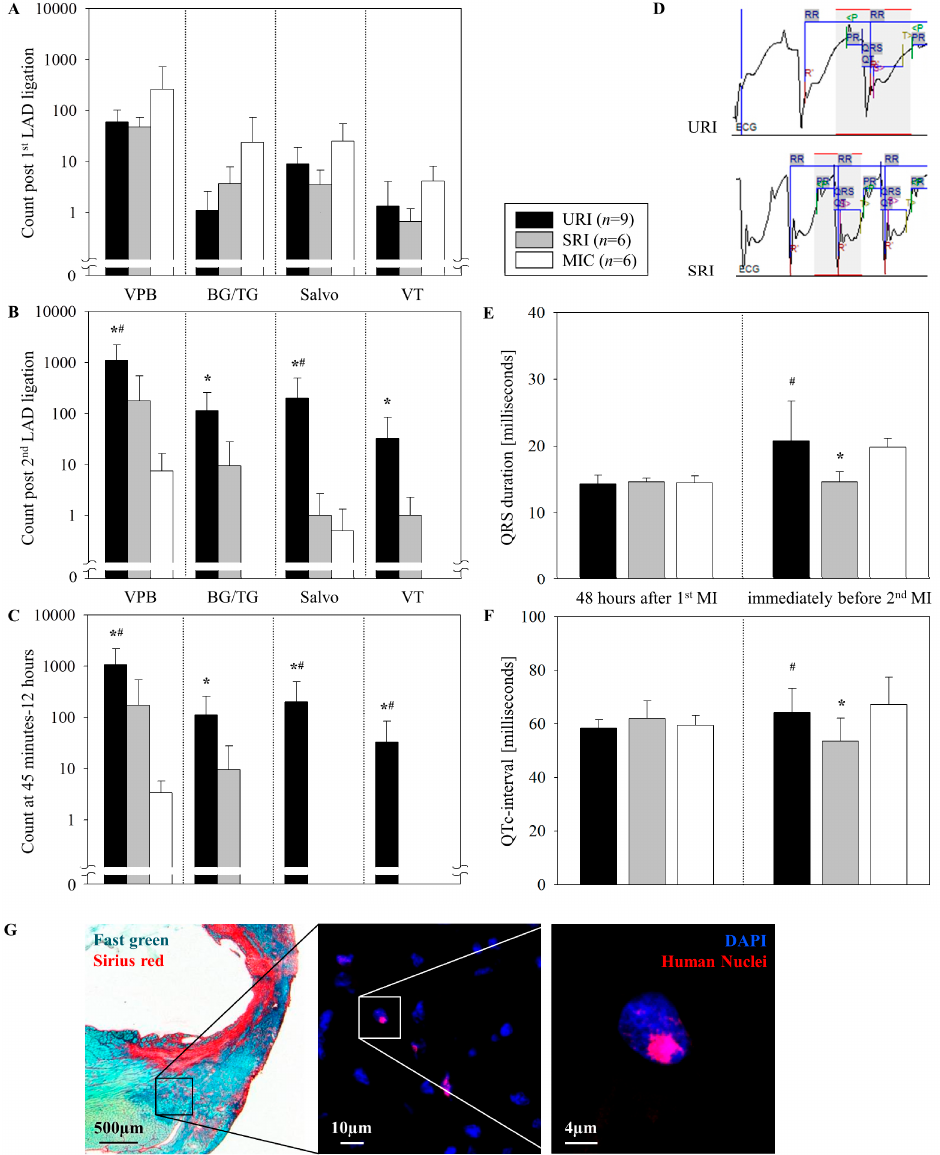
Figure 3. Comparison of developed VA. Until 12 h post LAD ligation ( A , B ). At the time period 45 min to 12 h post the second LAD ligation ( C ). ECG monitoring immediately prior to the second LAD ligation ( D ). QRS duration and QTc-interval 48 h post the first infarction and immediately prior to the second intervention ( E , F ). Mean ± SD, * p ≤ 0.05 as compared with MIC, # p ≤ 0.05 as compared with SRI (Mann–Whitney U Test). Representative images illustrate the engrafted human stem cells 9 days post transplantation performed for the SRI experimental group which the remaining human MSC were found predominantly in the peri-infarct area as with the Fast Green and Sirius Red staining method (the left picture) confirmed ( G ).